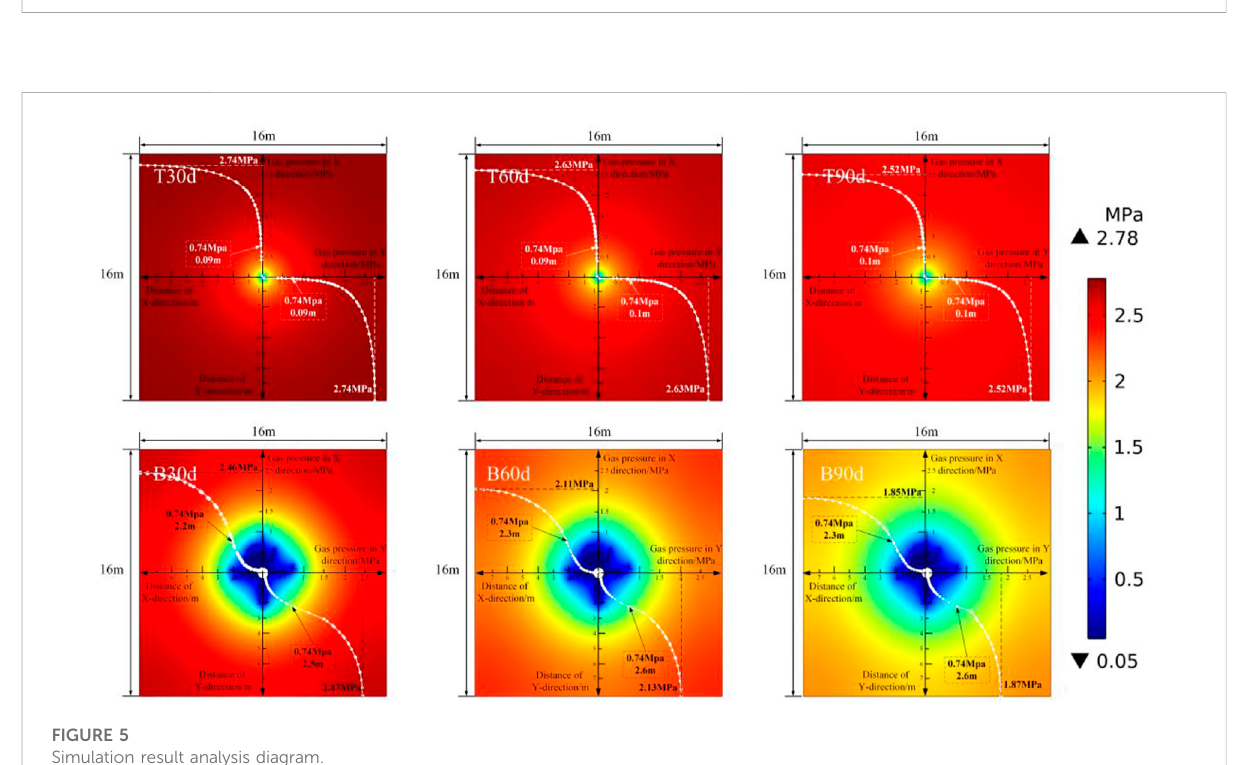
FIGURE 4 Original image of simulation results.